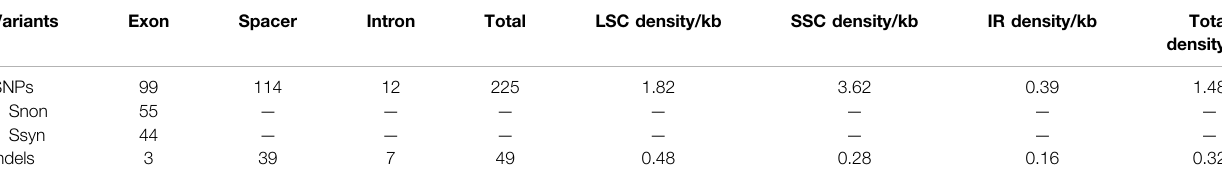
TABLE 3 | Summary of variants detected in L. cardiaca chloroplast genomes.